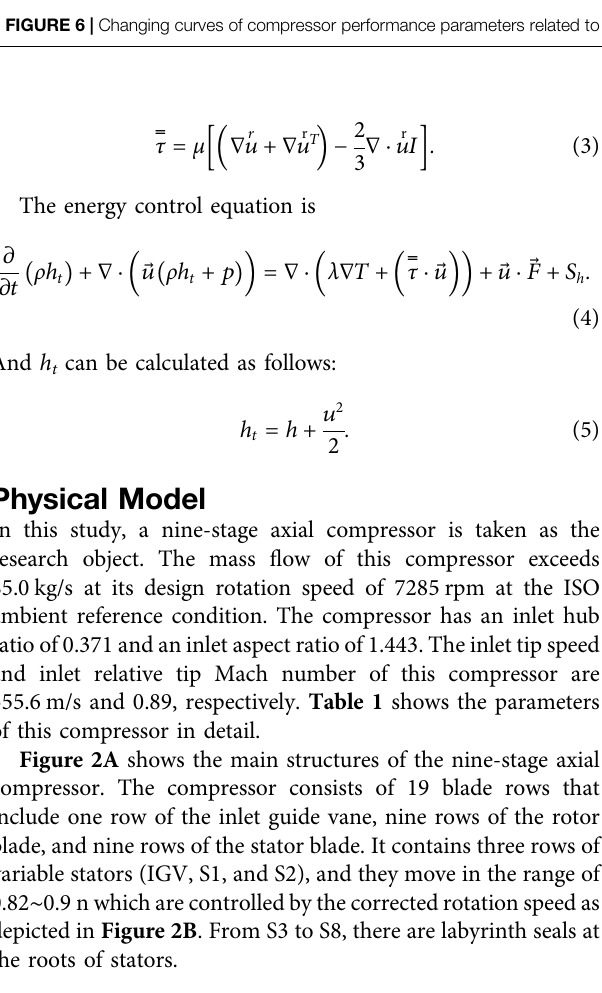
Frontiers in Energy Research |